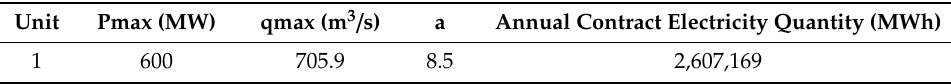
Table 5. The characteristic parameters of the hydropower Table 4. The thermoelectric relationship coefficient of thermoelectric units.